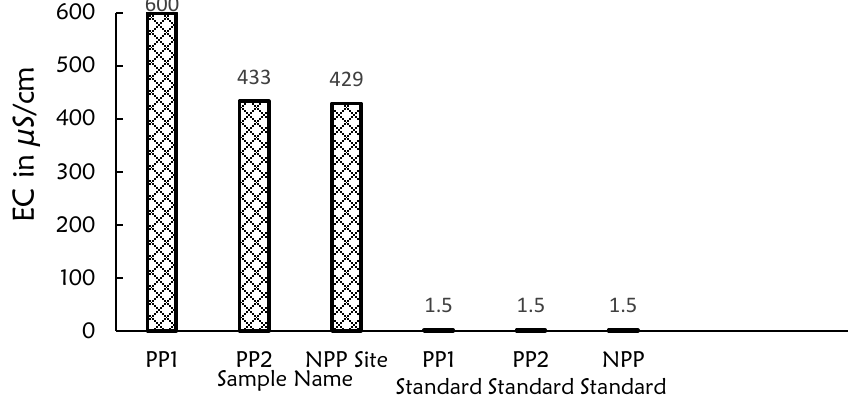
Figure 3: Analysis EC gap between raw water and DM